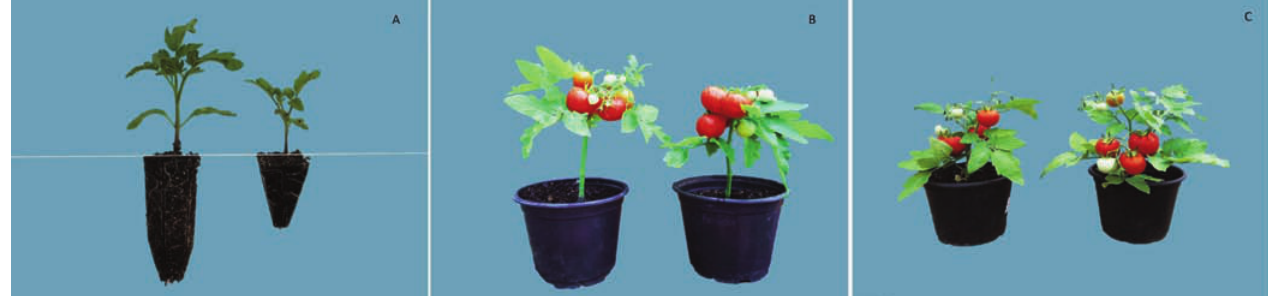
Fig. 1 - (A) Seedling plugs volume and visual comparison - 50 cm³ (left) and 18 cm³ (right); (B) plants from 50 cm³ plugs with hydrogel amendment (left) and without (right); (C) plants from 18 cm³ plugs with hydrogel amendment (left) and without